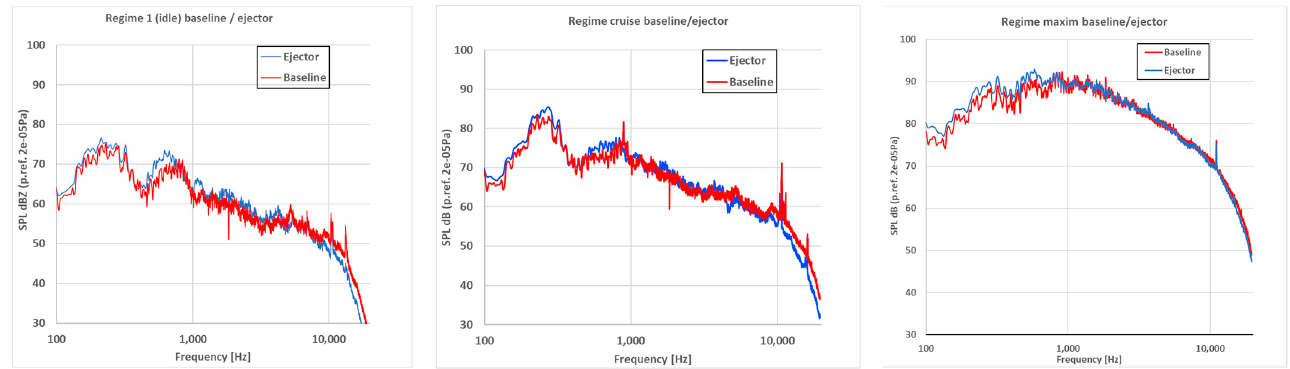
Figure 23. Averaged noise spectra for each configuration and regime.